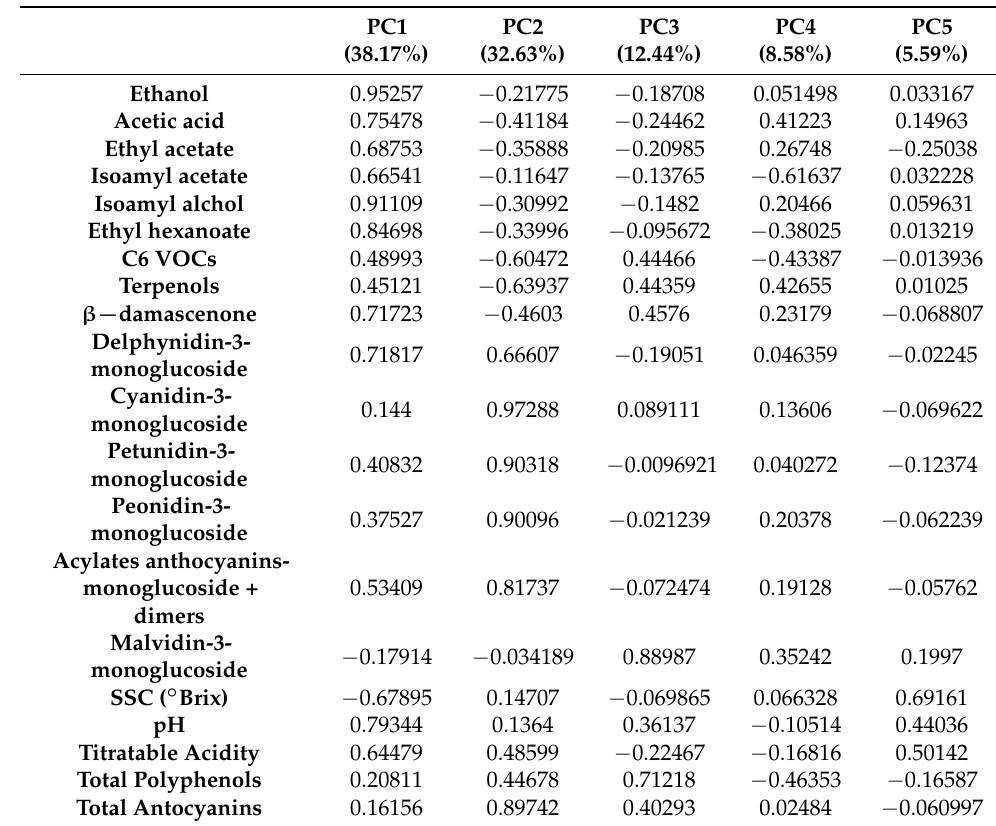
Table 4. PCA loadings values for the five principal components (PCs) describing residual explained variance at the 95% of the